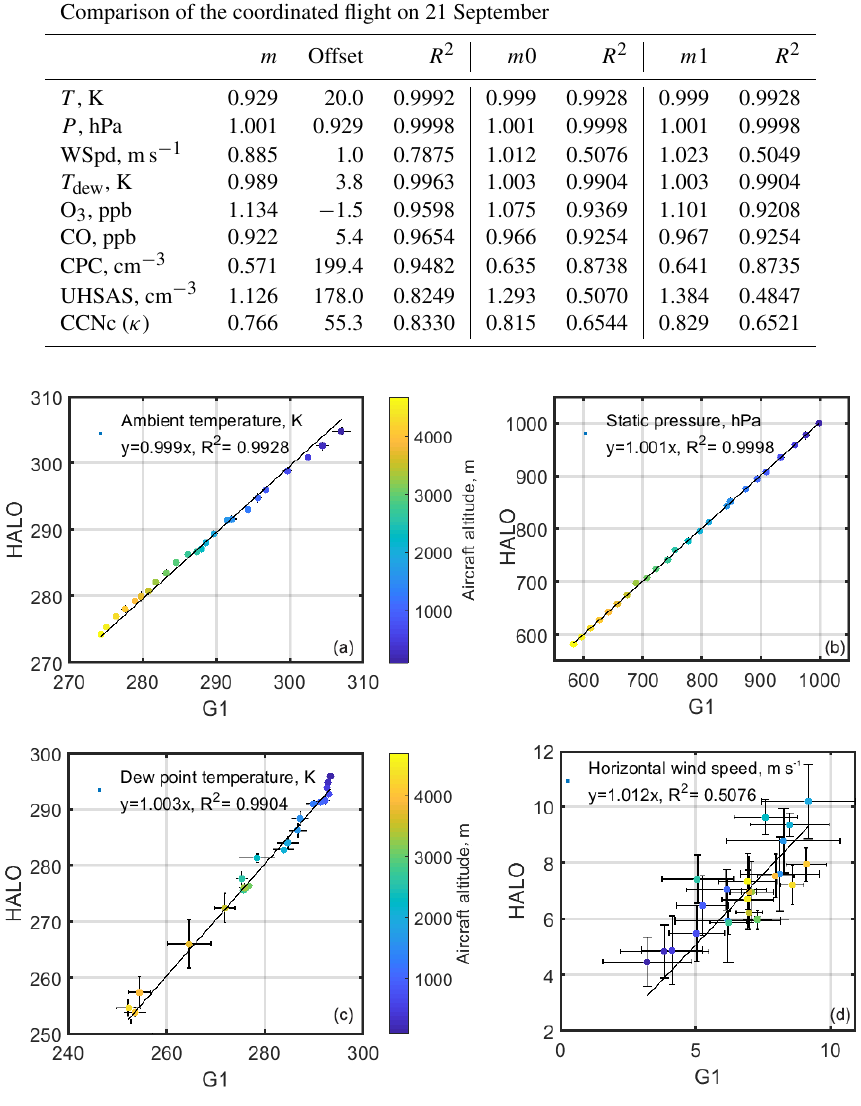
Figure 4. Aircraft altitude-colored plots of (a) ambient temperature, (b) static pressure, (c) dew-point temperature, and (d) horizontal wind speed observed by the G1 and HALO on 21